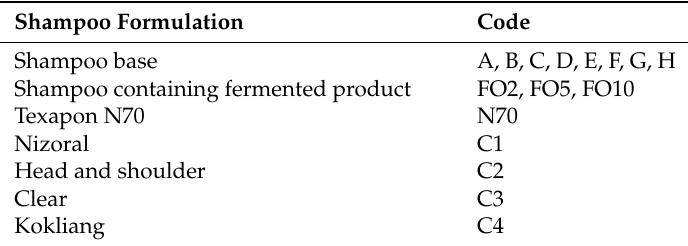
Table 2. Codes of shampoo